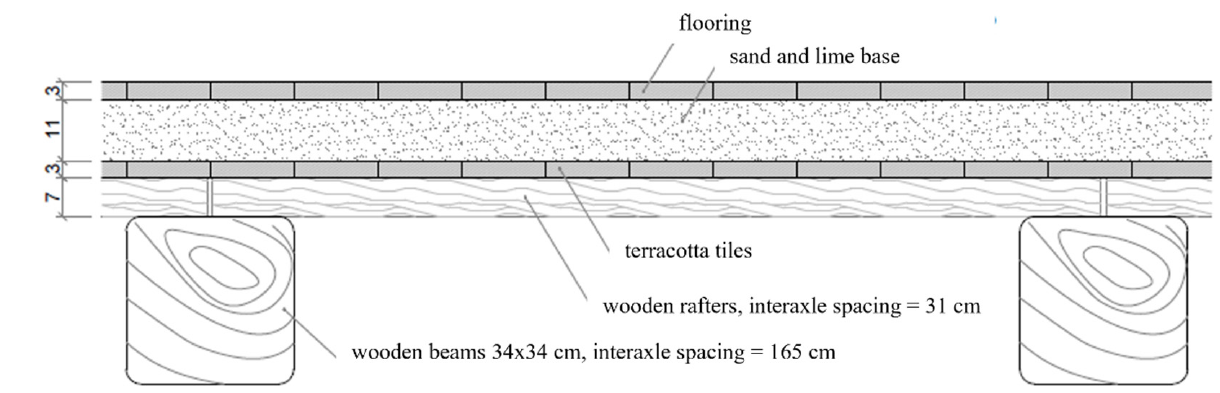
Figure 3. First and second floor slab (unit of measure is cm).